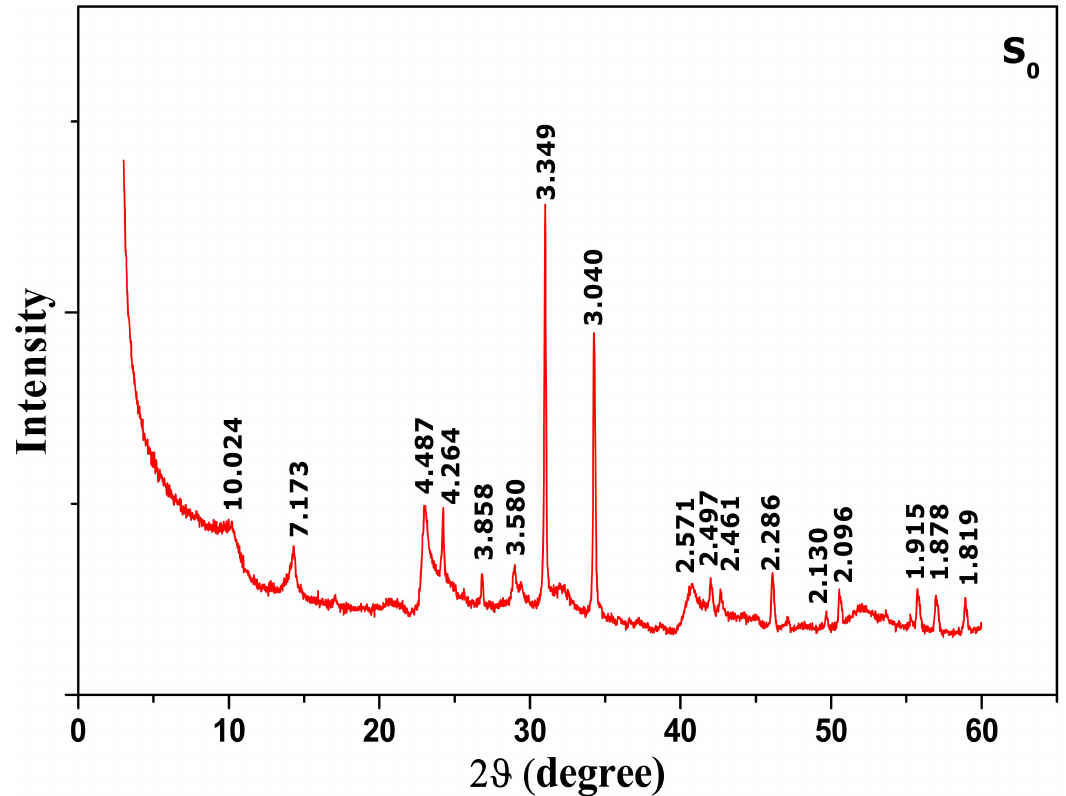
Figure 2. X-ray diffraction (XRD) patterns of raw material (S 0